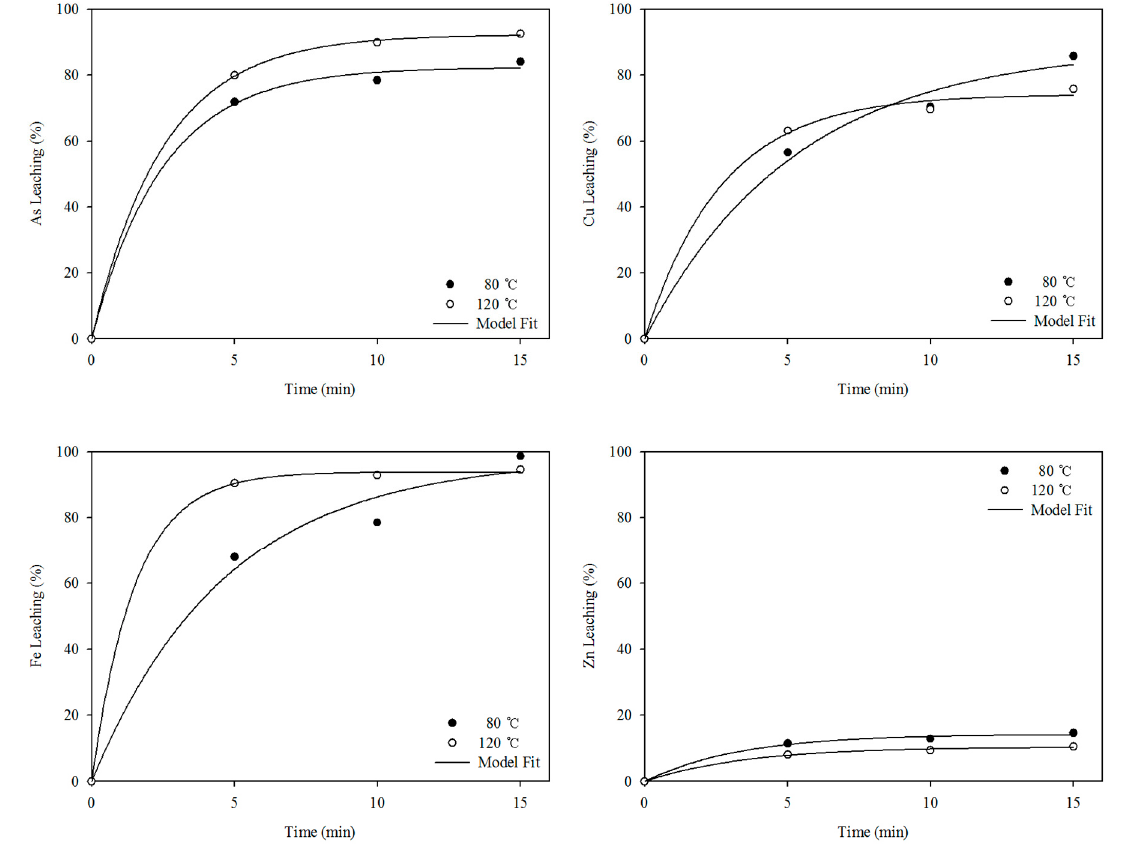
Figure 5. Effect of temperature on the leaching efficiencies of As, Cu, Zn, and Fe from the refractory gold concentrate. The leaching conditions were a reaction temperature between 80 and 120 °C, HNO 3 concentration of 1.0 M, and reaction time of 15 min. According to Equation (2) in Table 3.